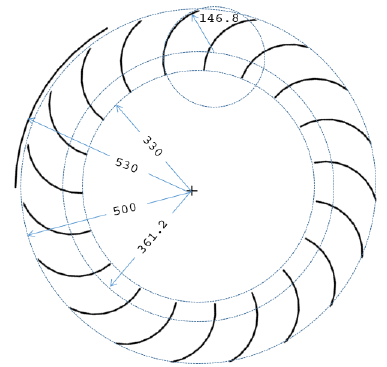
Figure 3. Dimensions of Banki wind turbine with 20 blades, units in mm.